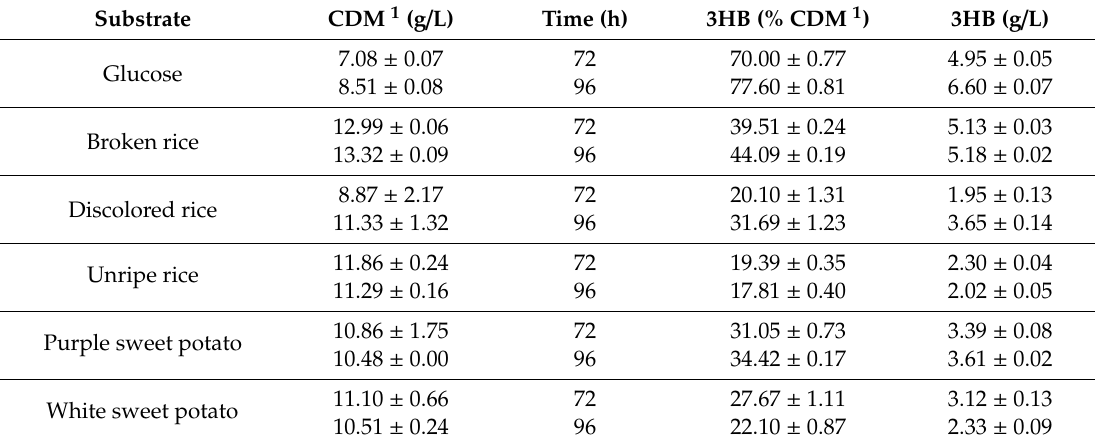
Table 2. Production of 3-hydroxybutyrate (3HB) by C. necator DSM 545 under the simultaneous saccharification and fermentation (SSF) experiments with 3% of rice by-products or sweet potato waste and a medium dosage of STARGEN ™ 002 (1.42 µ L per g of starch). As a benchmark, an experiment